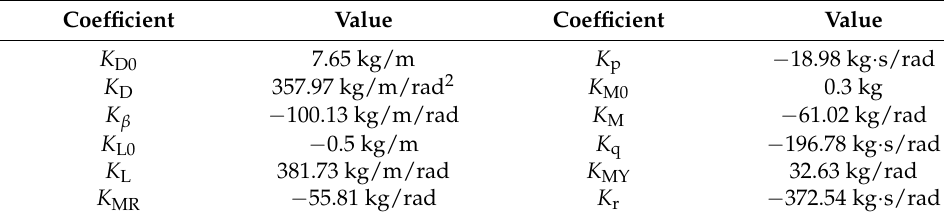
Table A3. Viscous hydrodynamic coefficients.